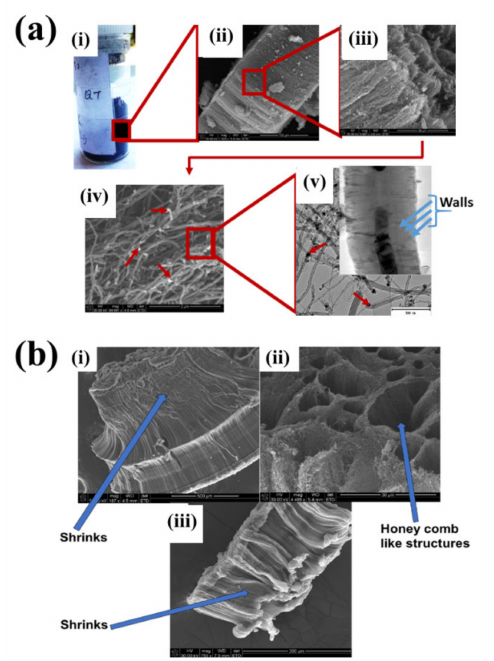
Figure 1. Multiwalled carbon nanotubes (MWCNTs) grown on quartz tube and acid treatment.